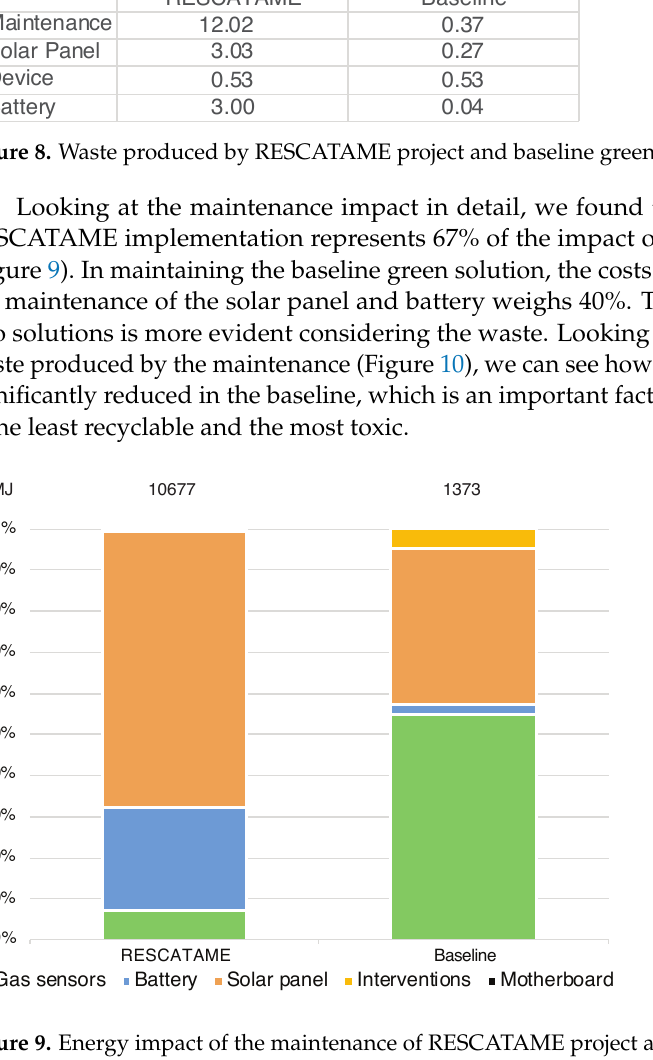
Figure 9. Energy impact of the maintenance of RESCATAME project and baseline green